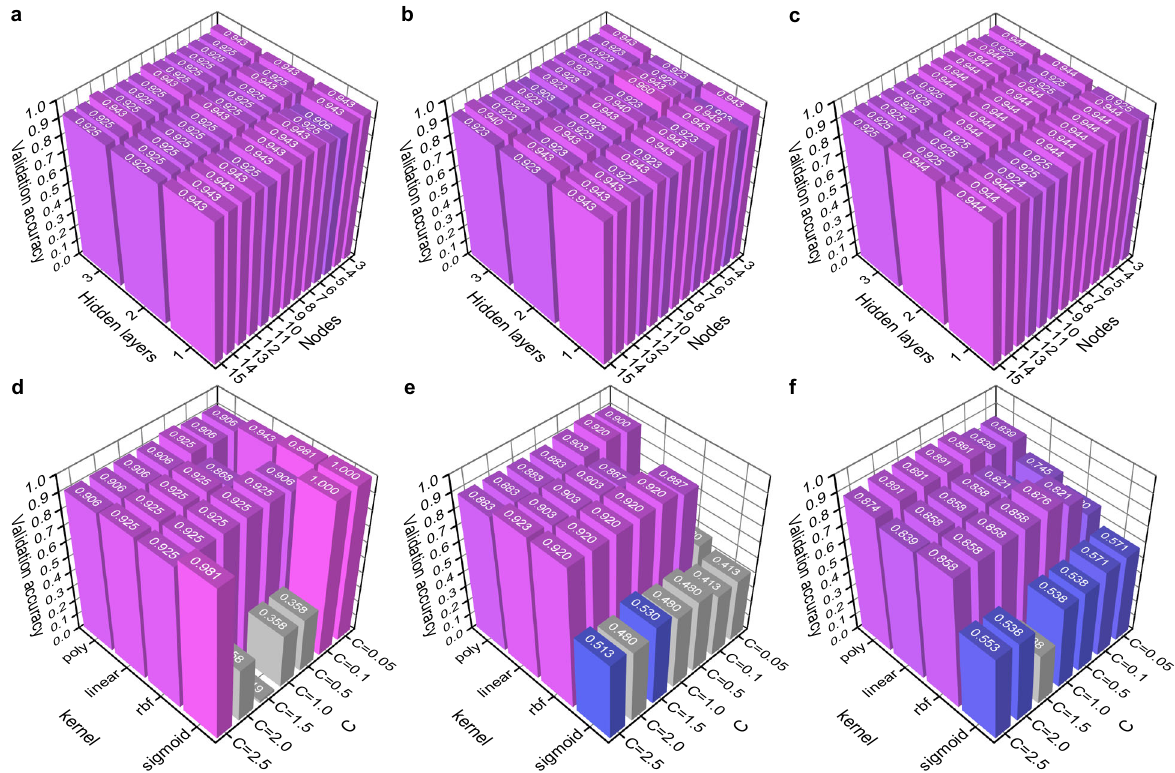
Fig. 2 Hyperparameters optimization of ML models. Hyperparameters of a – c ANN and d – f SVM models, respectively. The fi rst, second, and third columns refer to the LOO, 10-fold, and 5-fold methods, respectively. The validation accuracy is calculated by Eq. where N and acc i are the number of folds and the validation accuracy of each fold, respectively. The leave-one-out (LOO), 10- and 5-fold cross-validation methods were deployed to measure the performance of considered ML models. Speci fi cally, the dataset is split into N subsets in the N -fold cross-validation method. By using different subgroups as the test set, N independent models are trained and tested separately. In each model, the variables are trained on N − 1 subgroups and tested on the remaining group. For example, 10- and 5-fold cross-validation methods correspond to N = 10 and 5, indicating that the validation is performed within ten and fi ve machine learning models, respectively. In the LOO method, the number of folds is equal to the dataset size, and only one data is left in the validation set; while the rest data are included in the training set. Results in Fig. 2 show that the validation accuracies of ANN